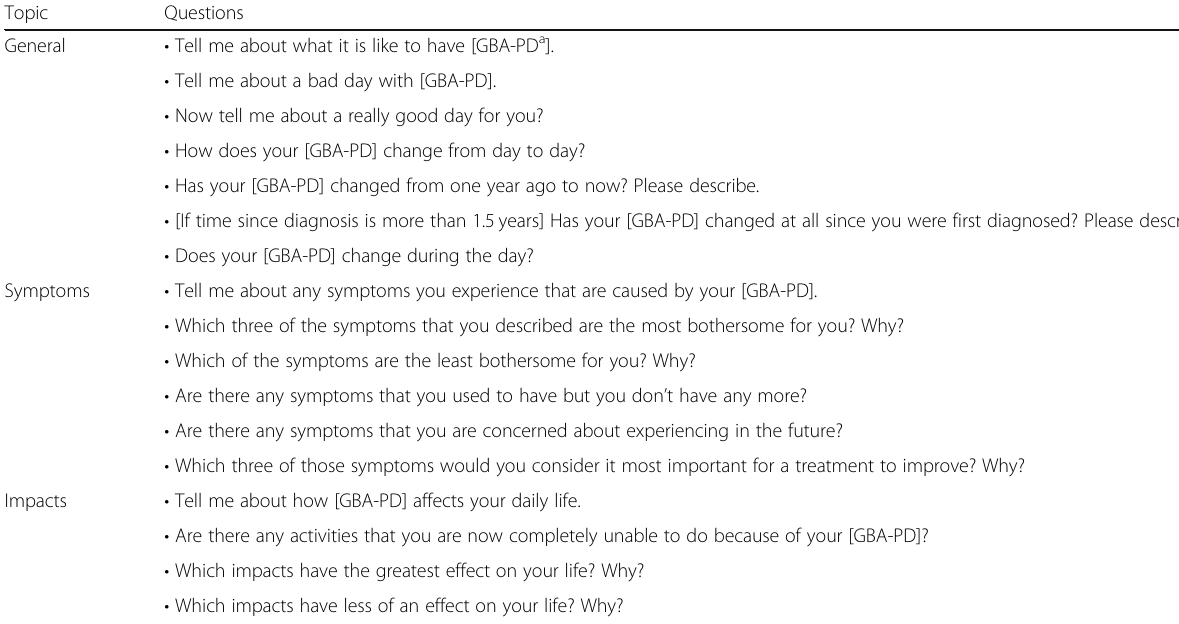
Table 1 Examples of open-ended questioning from the patient semi-structured interview guide Topic